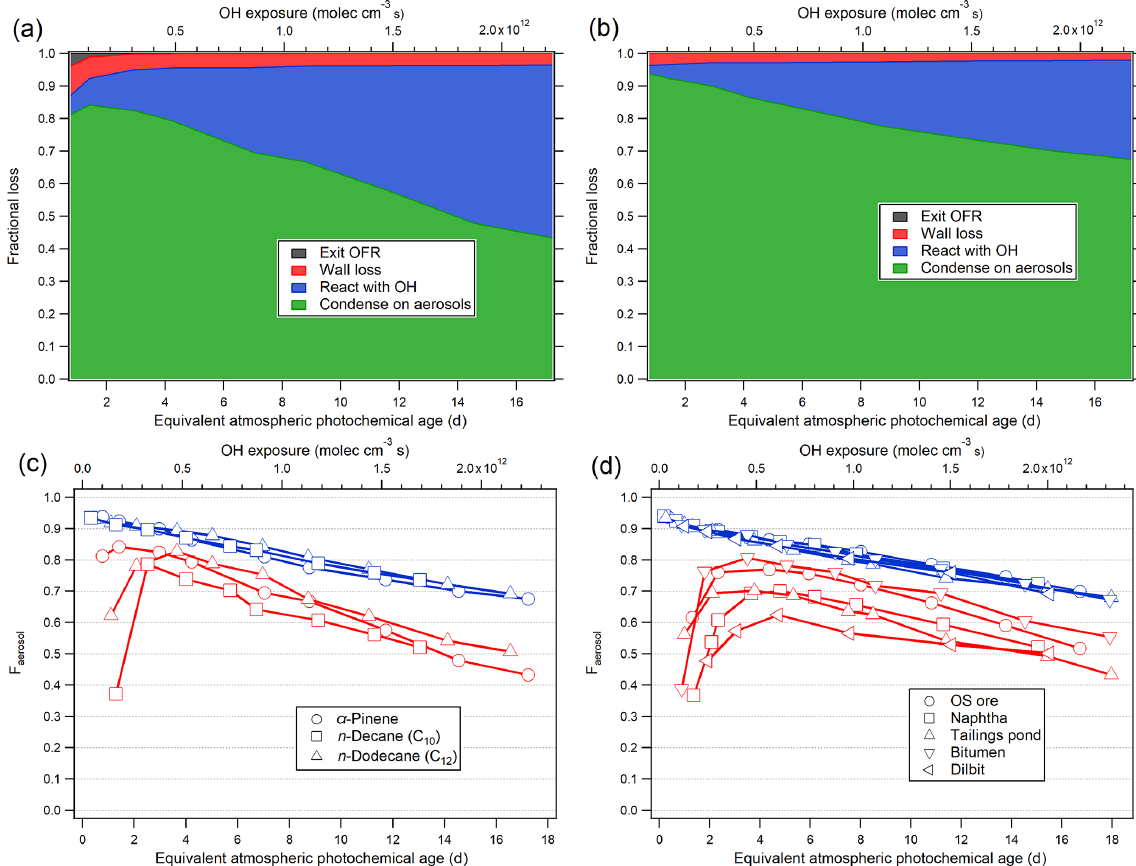
Figure 4. (a, b) The modeled fate of LVOCs in the current OFR as a function of photochemical age, for α -pinene oxidation, in the absence (a) and presence (b) of AS seed particles. (c, d) Fraction of LVOCs that condense on aerosol ( F aerosol ) in the OFR during the oxidation of the single precursors (c) and various OS-related precursors (d) (blue: seeded experiments; red: unseeded